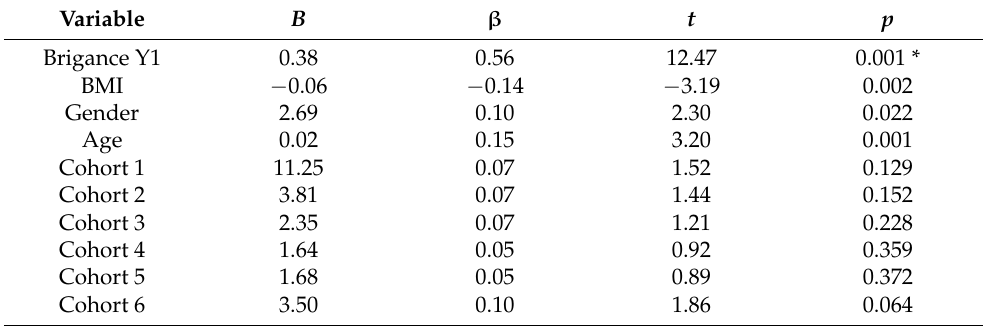
Table 1. The Multiple Regression Coefficients for BMI Percentile Prospectively Predicting Cognitive Development One Year